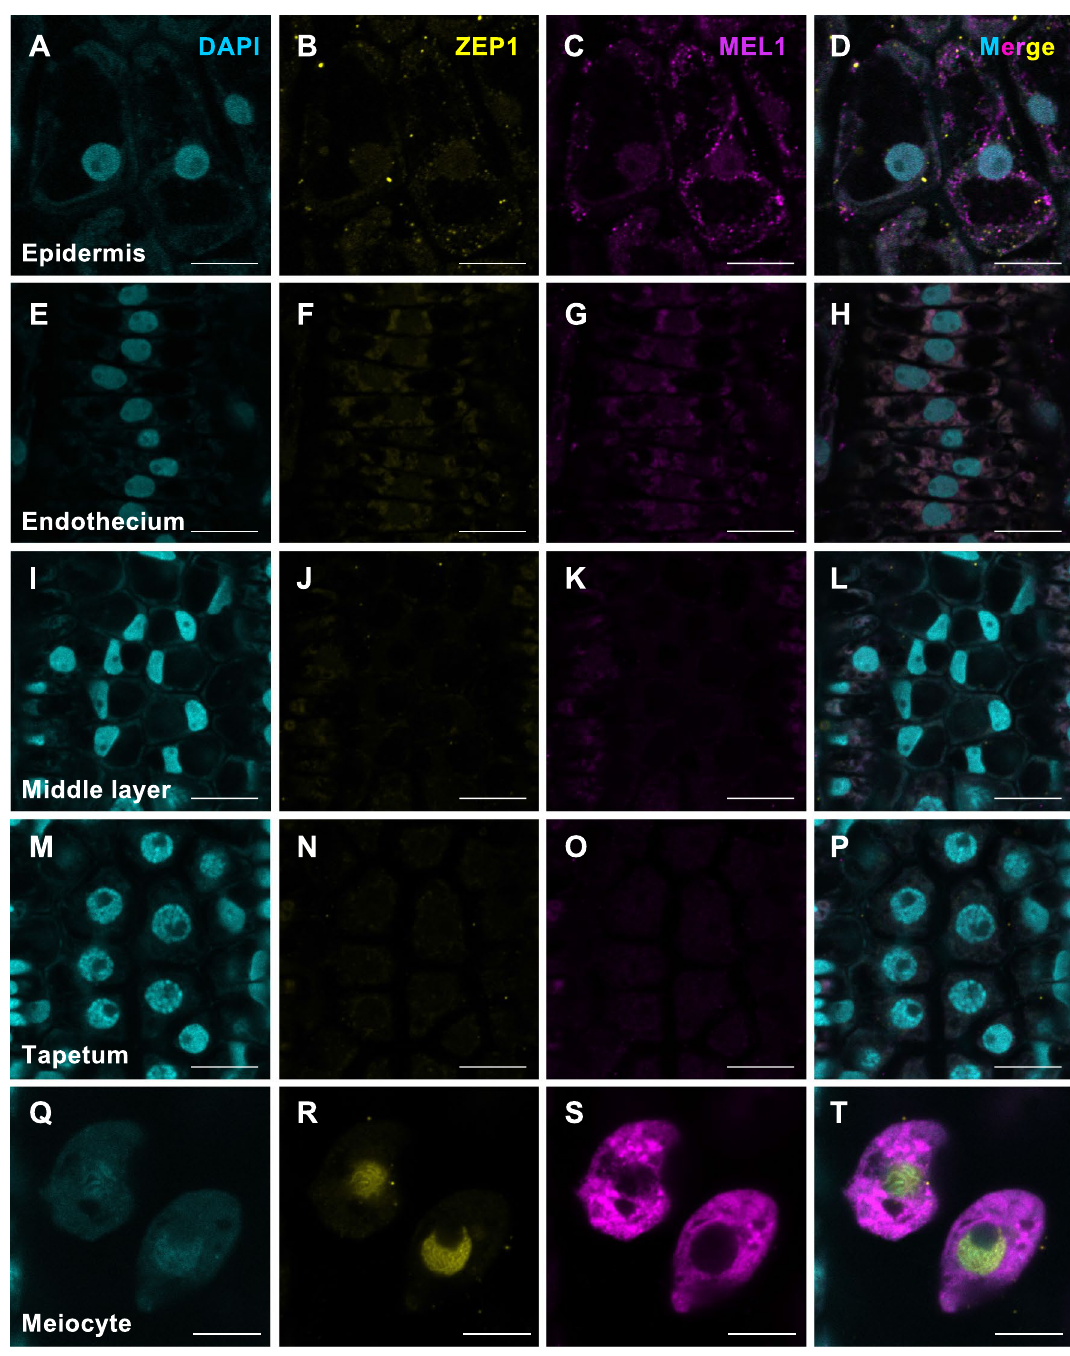
Figure 4. Single-cell morphology and MEL1/ZEP1 subcellular localization using the whole-anther immunostaining method. ( A , E , I , M , Q ) DAPI signals (cyan) in 3D multiple immunoimaging using 0.65-mm-long whole anthers at early meiosis. ( B , F , J , N , R ) 3D multiple immunoimaging to detect ZEP1 (yellow). ( C , G , K , O , S) 3D multiple immunoimaging to detect MEL1 (magenta). ( D , H , L , P , T ) Merged images